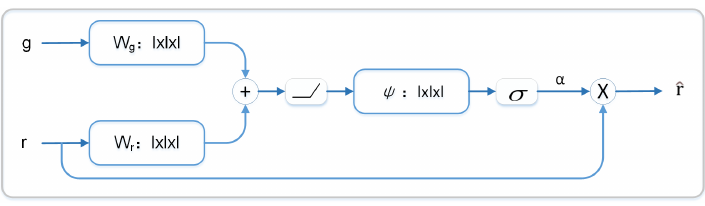
Figure 2. Attention